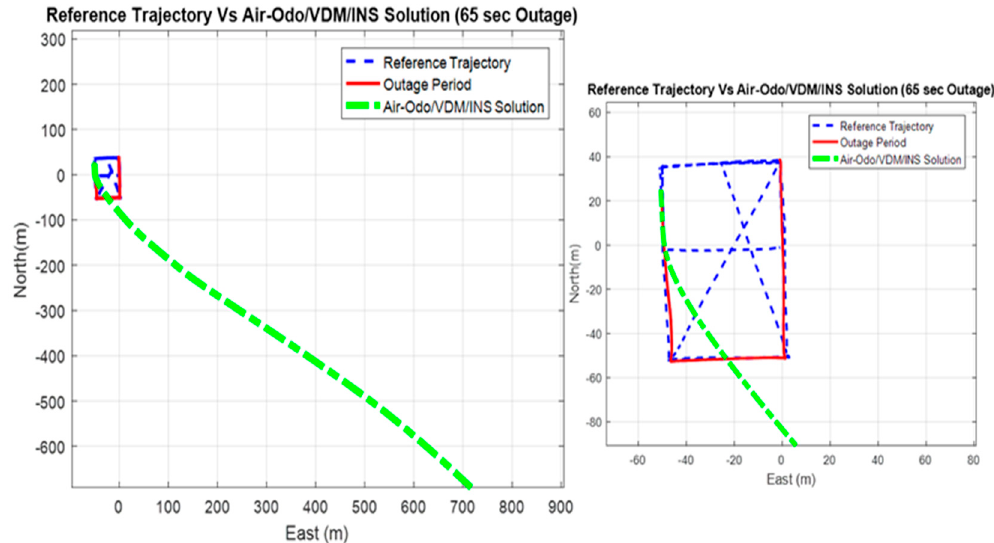
Figure 11. INS standalone navigational solution, showing the massive drift exhibited by the INS when there is no aiding sensor to bound the massive accumulation of errors.